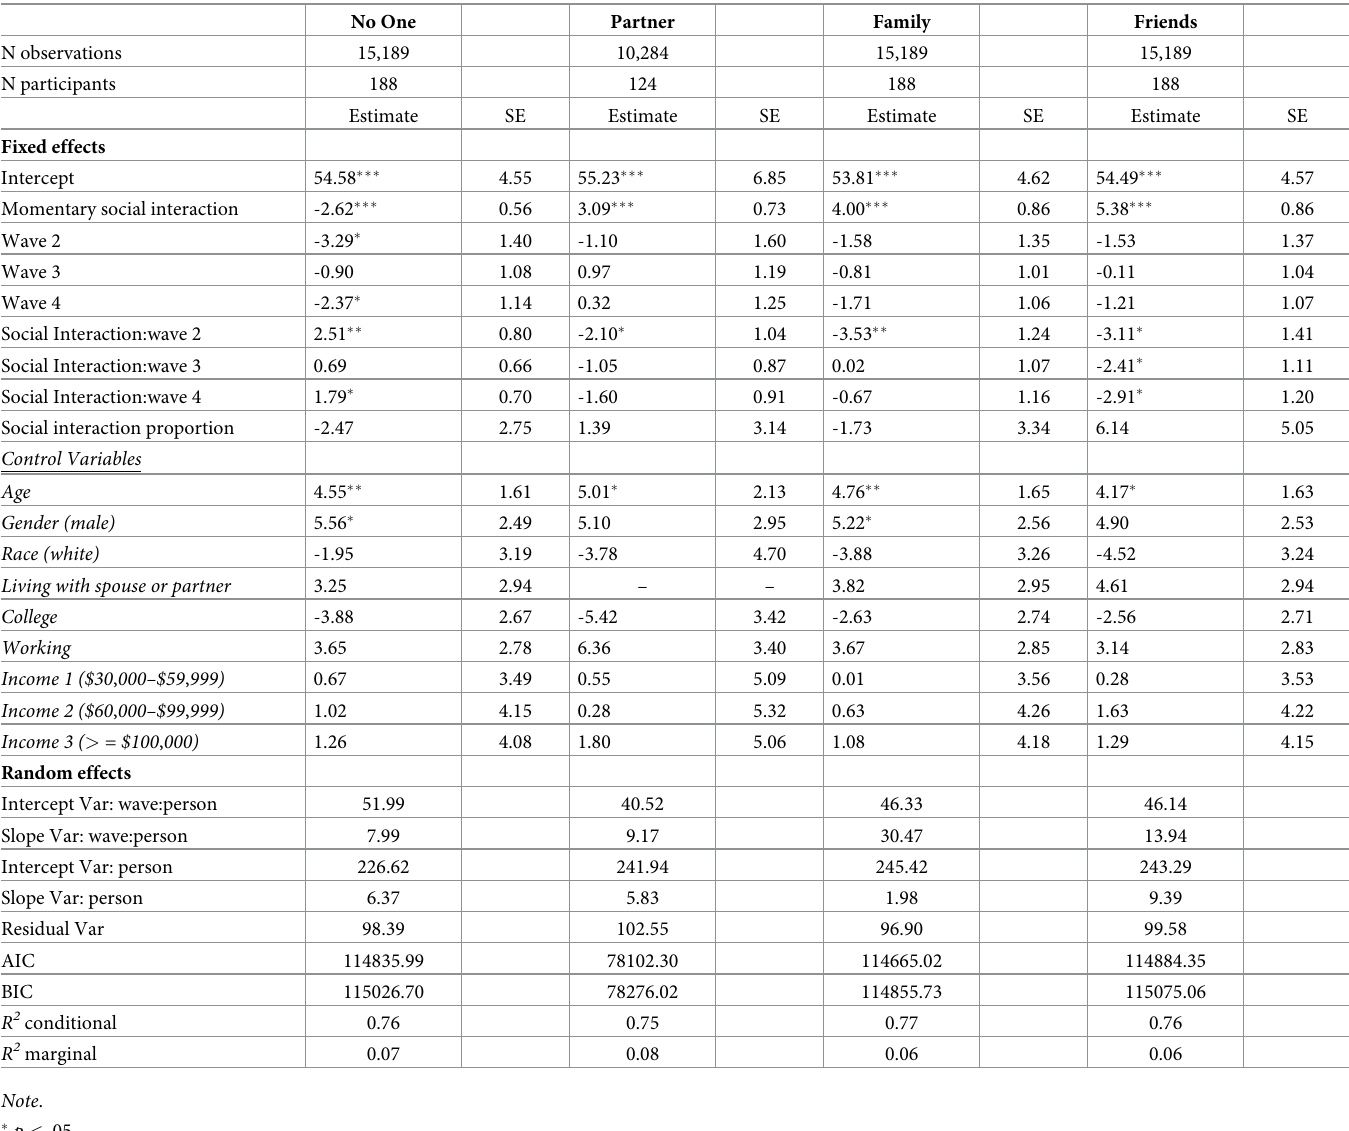
Table 6. Multilevel models with various social interactions, wave, and social interactions by wave predicting